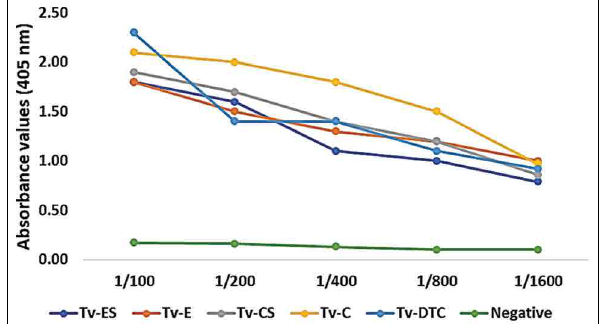
Figure-7: Screening of enzyme-linked immunosorbent assay calibration. Negative calves’ sera (n=5) and positive calves’ sera (n=9) were calibrated against five protein antigens of Toxocara vitulorum at a concentration of 10 µ